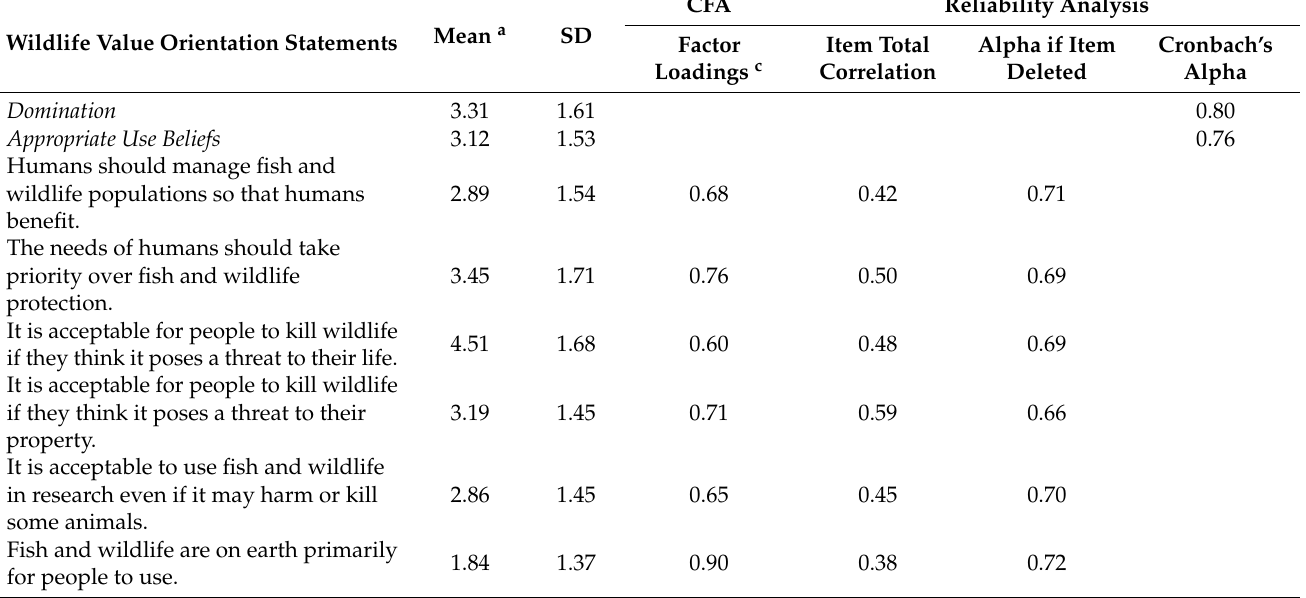
Table 2. Descriptive statistics, reliability and confirmatory factor analysis (CFA) of wildlife value orientation